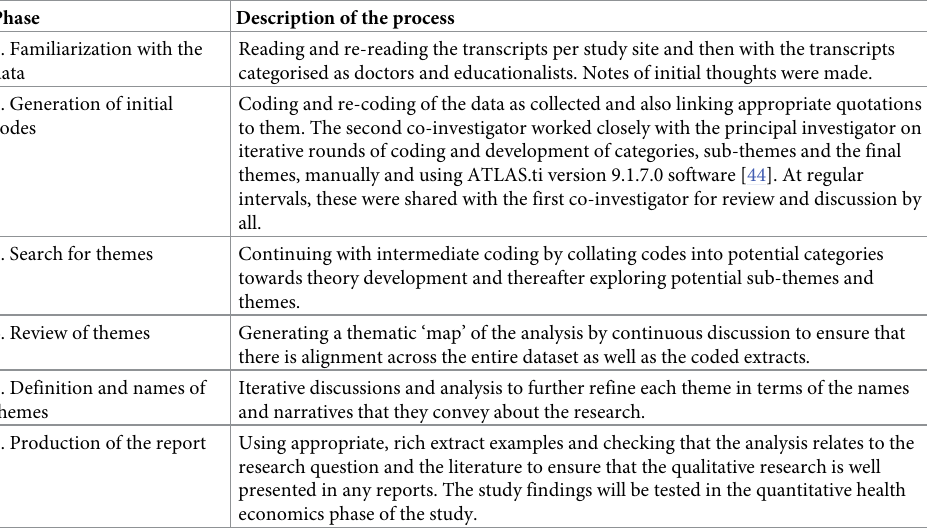
Table 1. Phases of thematic analysis adapted for the